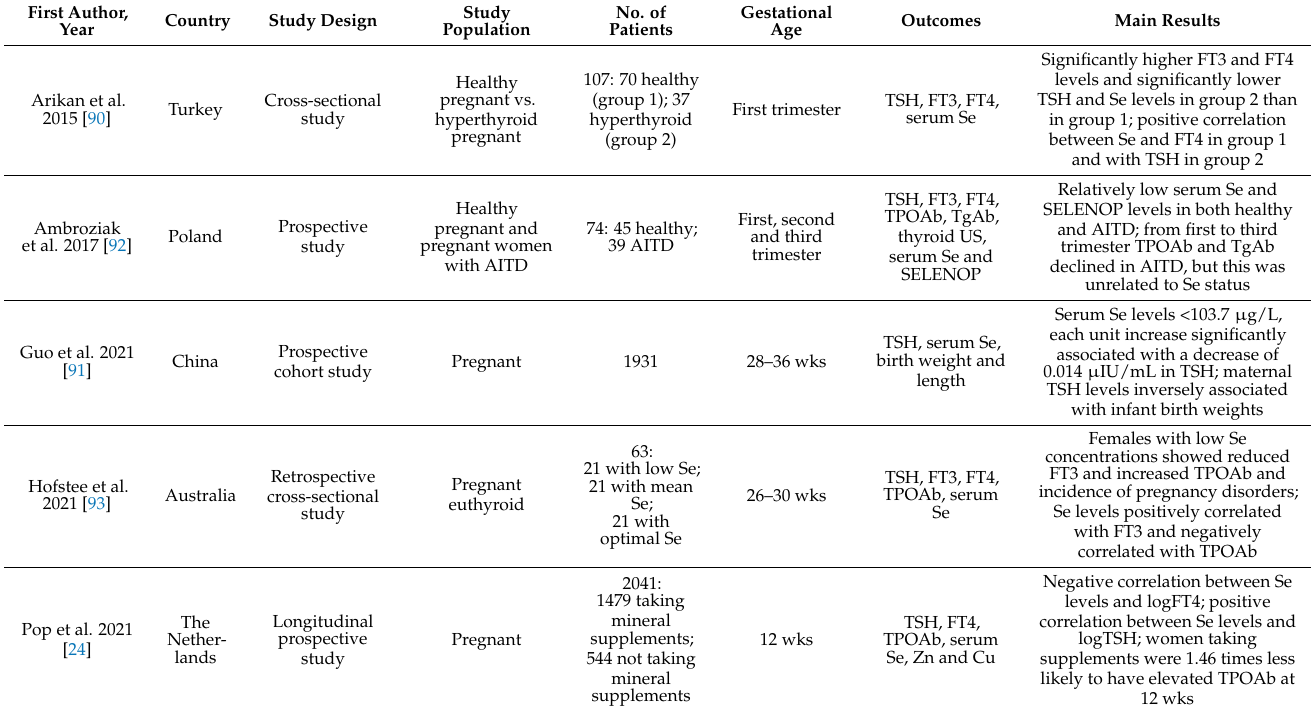
Table 2. Details of studies evaluating selenium status and thyroid outcomes in pregnant